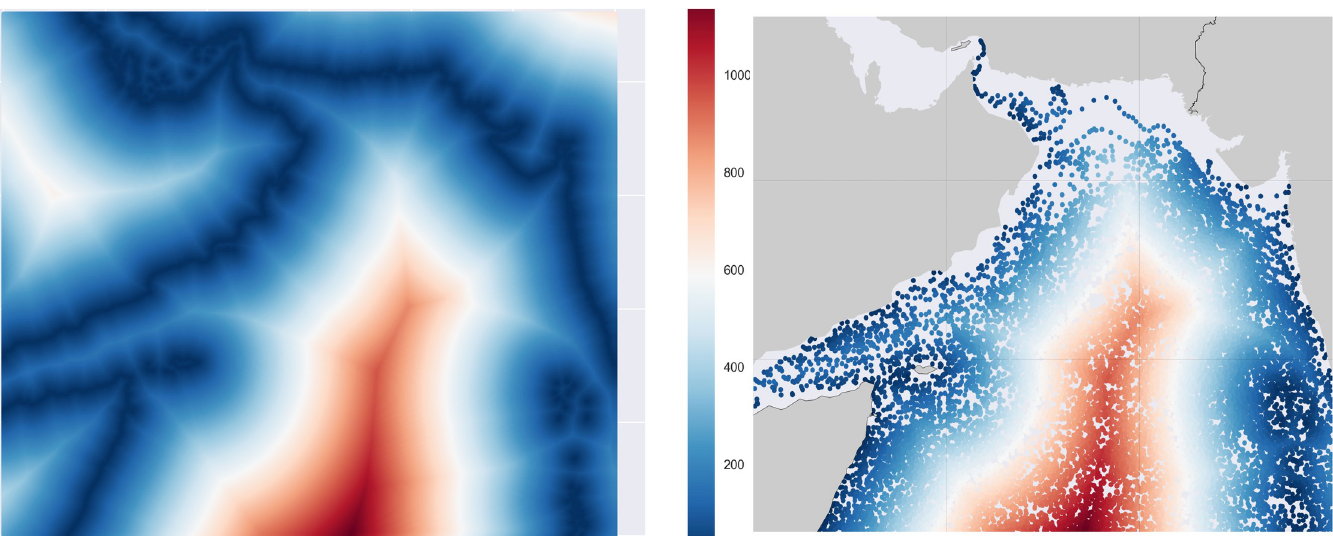
Fig 4. (A) Distance to the nearest coast for all the geographical locations in the Arabian Sea Region. (B) Interpolated values of the distance to the nearest coast for all the data points in the drifter